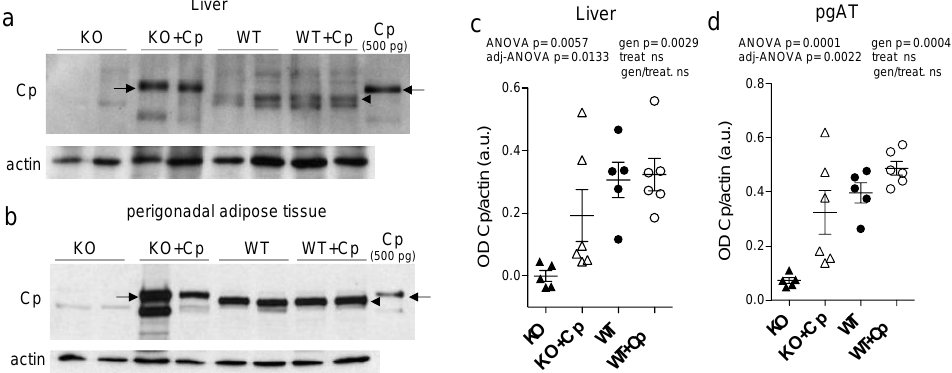
Figure 2. Cp level in liver and perigonadal adipose tissue of CpKO mice treated with Cp. ( a , b ) Western blot analysis of Cp and actin levels in liver ( a ) and pgAT ( b ) of mice treated for 2 months with intraperitoneal injection of Cp 5 μg/g , administered every 5 days (KO+Cp; WT+Cp) or saline (KO, WT) (arrow = administered Cp; arrowhead = endogenous Cp); purified Cp was run as control (lanes on the right). Cropped images are from the same or twin SDS-PAGE and Western blot but at different exposure. ( c , d ) Densitometric analysis of Cp Western blot signals in liver ( c ) and pgAT ( d ) performed with ImageJ software; values are reported as optical density normalized for actin. Data: mean ± SEM of animal groups, each dot corresponds to one mouse (CpKO, WT n = 5; CpKO+Cp, WT+Cp n = 6); statistical p values were evaluated by two-ways ANOVA and reported as value for overall ANOVA, value for Benjamini-Hochberg adjustment for multiple ANOVA tests related respectively to liver and adipose tissue features (adj-ANOVA), for genotype variable (gen), for treatment variable (treat) and for the interaction of genotype/treatment (gen/treat).